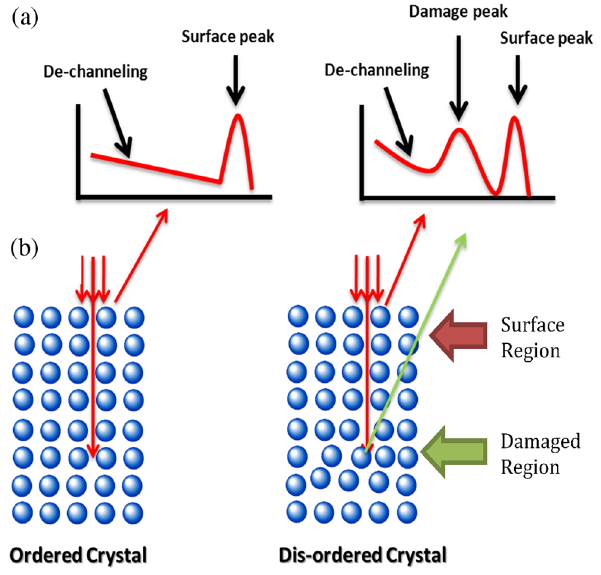
FIG. 3. Schematic of RBS spectra of channeling scattering mechanisms in ordered and disordered single crystals.